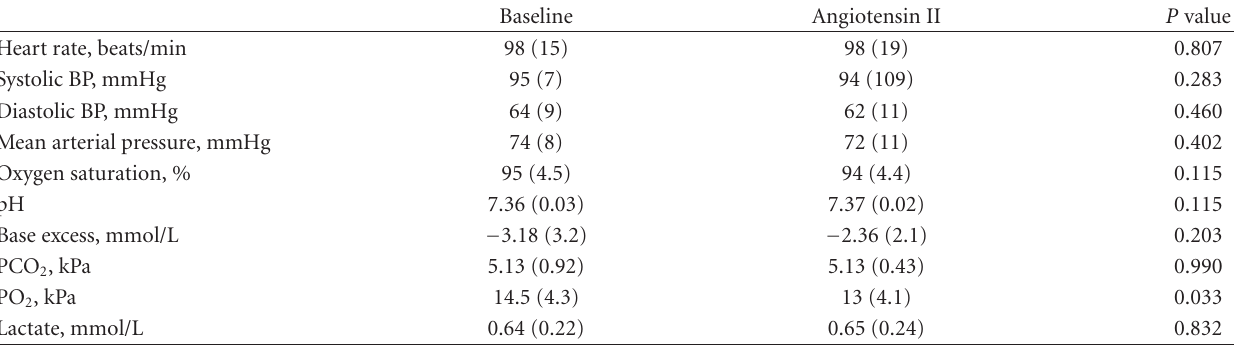
Figure 1: Tissue Doppler-derived left ventricular longitudinal myocardial velocities at the level of mitral valve annulus obtained from a near-term sheep fetus. Isovolumic contraction velocity (IVCV), isovolumic contraction time (IVCT), velocity during ventricular systole (S (cid:3) ), isovolumic relaxation velocity (IVRV), isovolumic relaxation time (IVRT), ejection time (ET), velocities during early ventricular filling (E (cid:3) ), and atrial contraction (A (cid:3) ) phases of the cardiac cycle. Table 1: Invasively monitored maternal hemodynamic parameters and acid-base status at baseline and during fetal angiotensin II infusion. Data are presented as mean